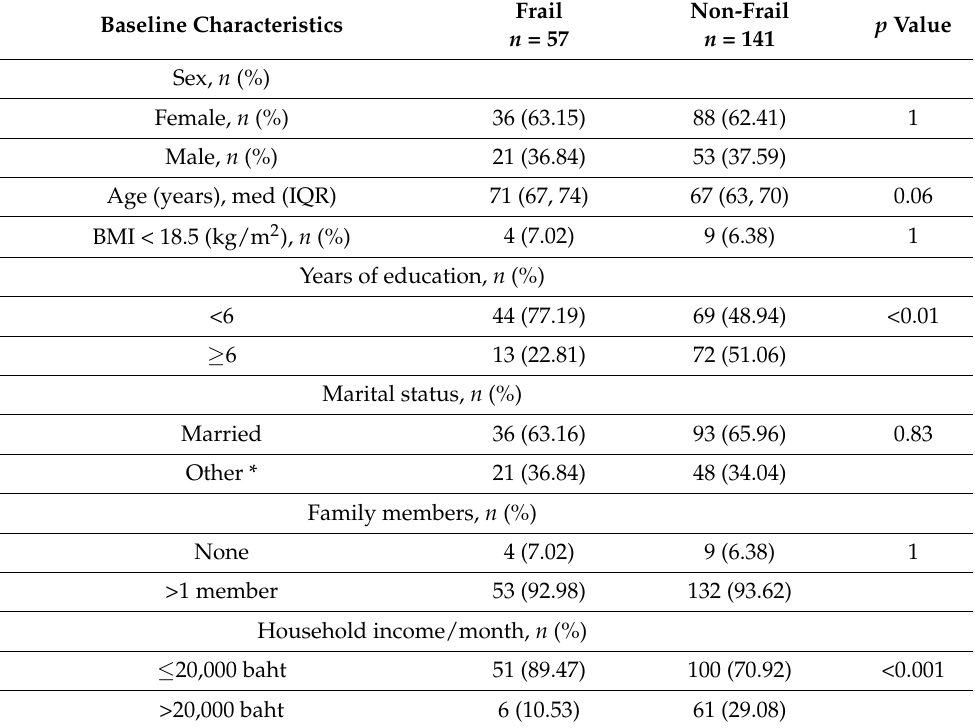
Table 1. Demographic data of the studied population. Baseline